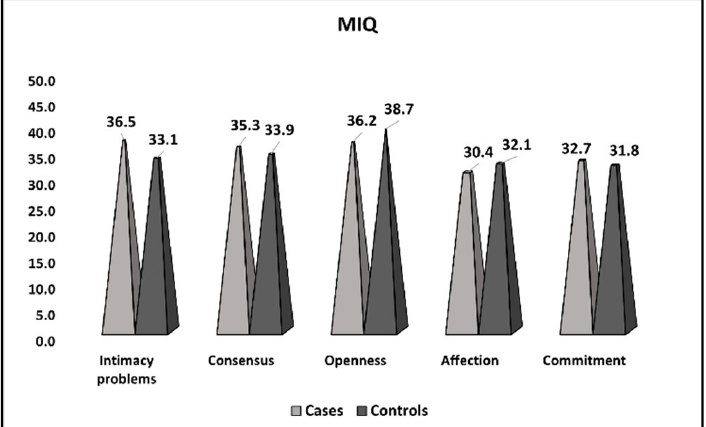
Figure 3. Comparison of MIQ survey results between women with thrombophilia and recurrent pregnancy loss (cases), women with thrombophilia and recurrent pregnancy loss who achieved a normal pregnancy, and preterm or full-term birth (controls).